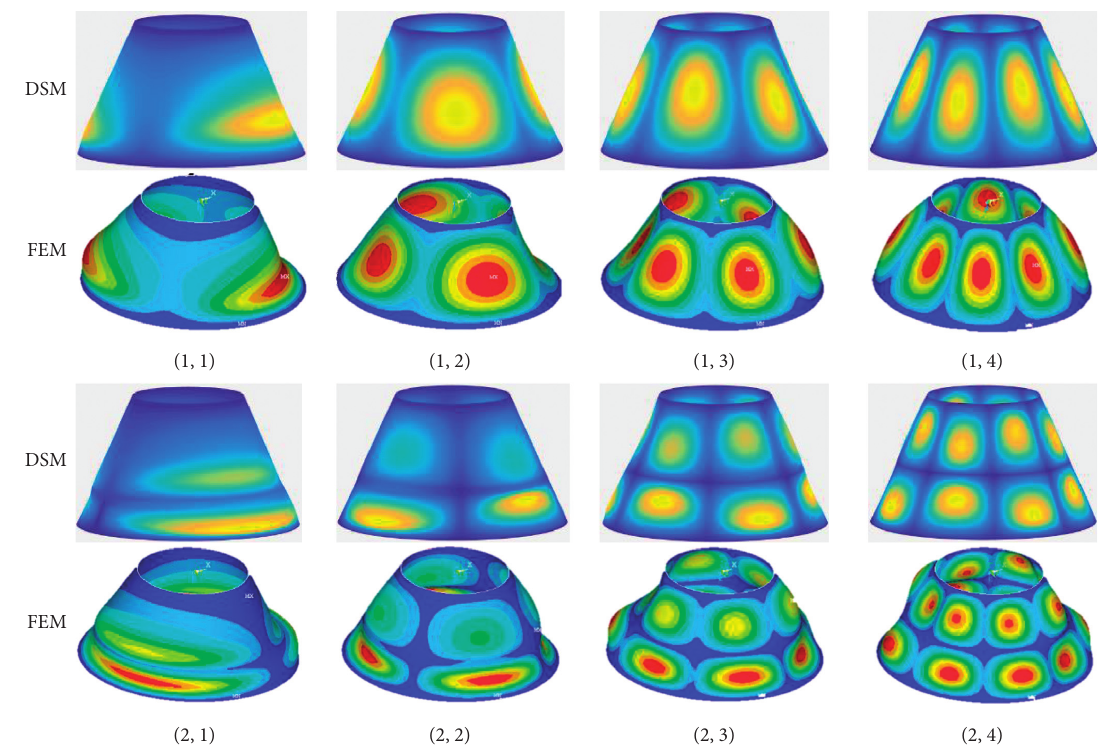
Figure 6: Mode shapes of conical shell under C–C boundary condition.